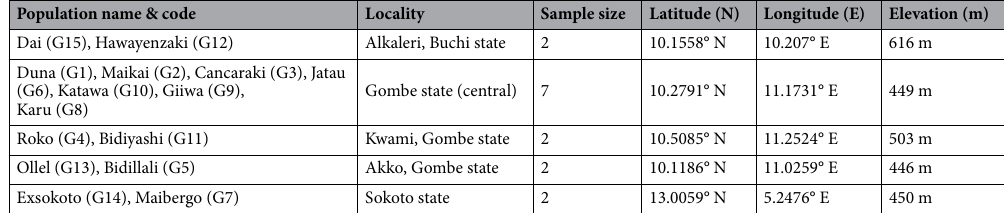
Table 1. The line-up of Bambara groundnut accessions with source of